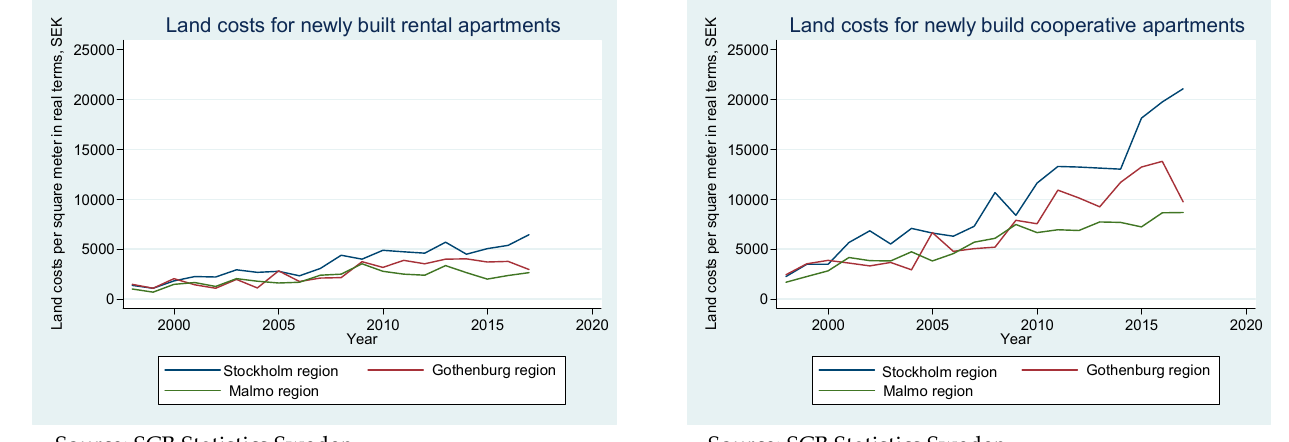
Figure 12. Land costs in the three largest urban areas in Sweden for construction: ( a ) rental apartments; ( b ) housing cooperative apartments.